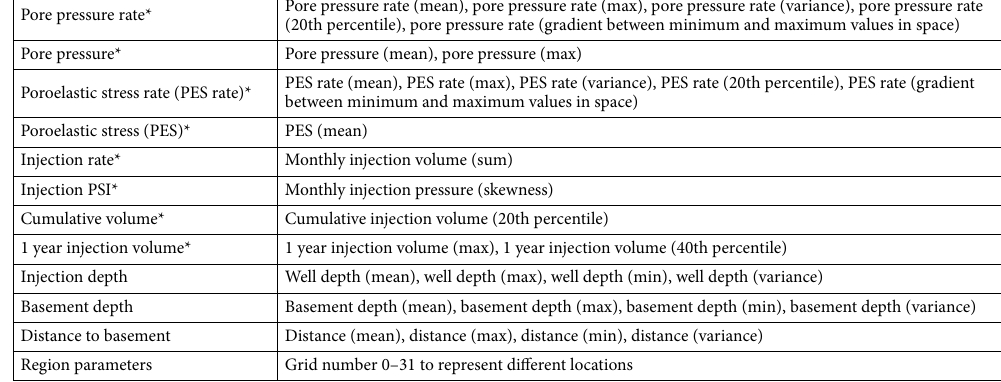
Table 1. The list of selected input features for Random Forest forecast. The complete input features also include the history data of the features denoted by asterisk